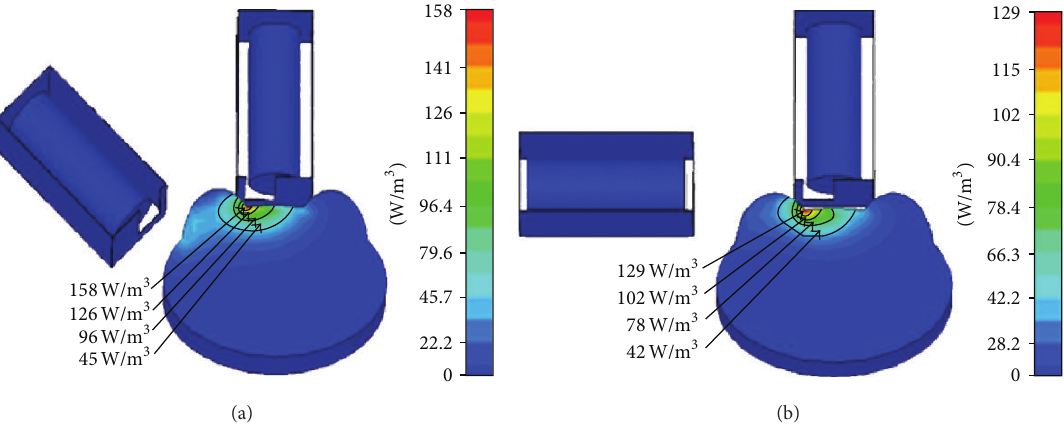
Figure 6: Electric loss density of the heating model for ferrite cores orientations (a) 45 degrees (b) 90